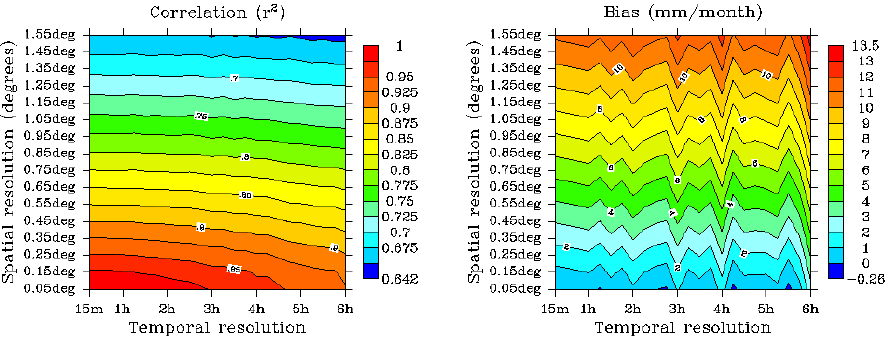
Figure 4. An example of monthly-aggregated precipitation simulations at several spatial